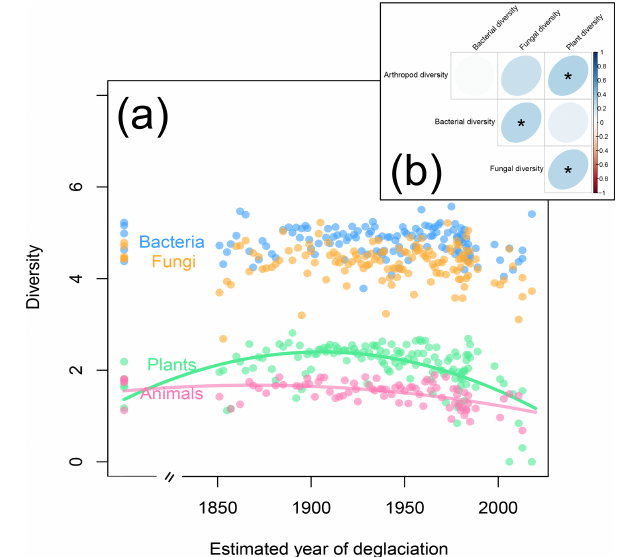
Figure 6. Shannon diversity of plants, animals, fungi, and bacte- ria as a function of plot age. (a) As with plant diversity (see also Fig. 3b), animal diversity increases in the first years of the succes- sion but slightly decreases on the oldest plots. In contrast, bacterial and fungal diversities vary independently of plot age. (b) Correla- tions between plant, animal, bacterial, and fungal diversity across the study plots. Significant correlations are marked by